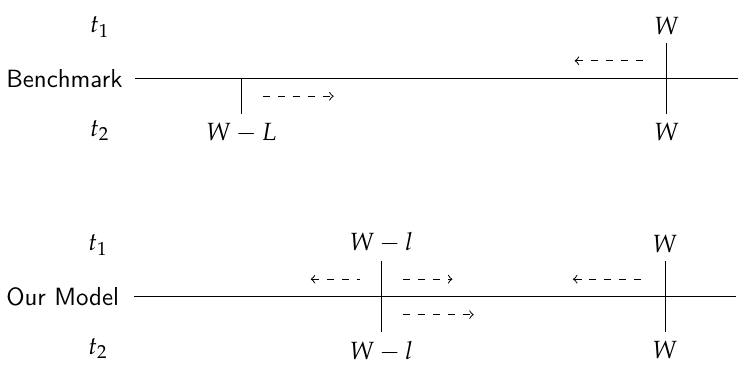
Figure 3. Wealth prospects with insurance (a).